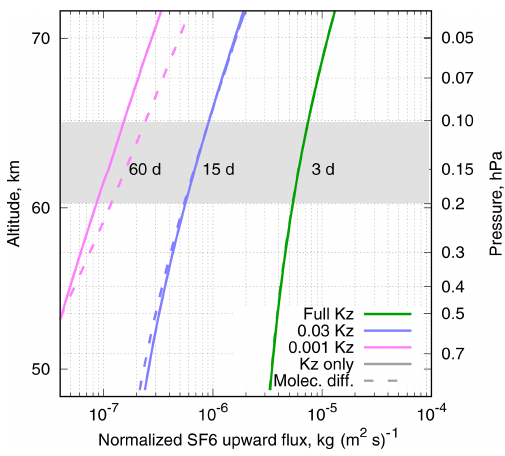
Figure 3. Vertical profiles of steady-state upward flux of SF 6 nor- malized with mass mixing ratio, F(p)/ξ(p) , for eddy-diffusivity and lifetime profiles given by Eqs. (1) and (6). The topmost model layer of SILAM and effective lifetimes of SF 6 there due to the de- struction in the mesosphere for different K z profiles are